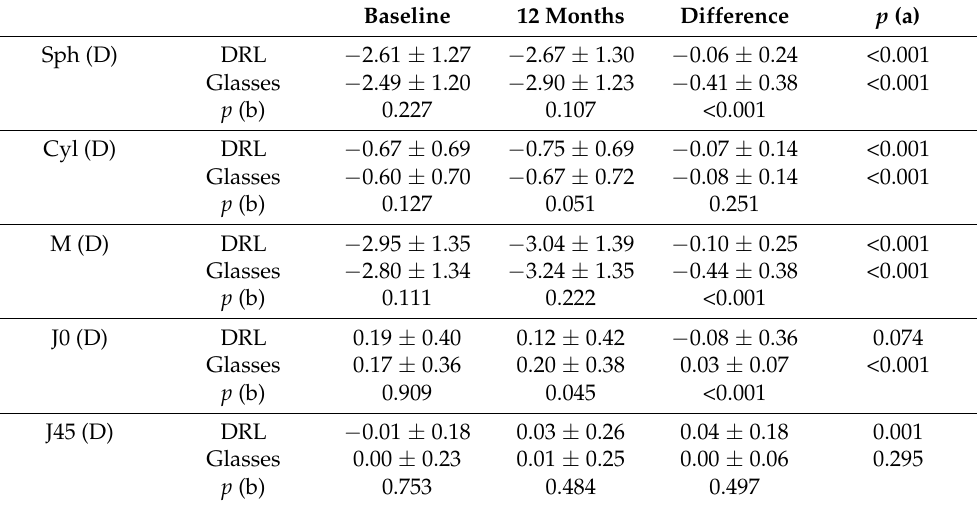
Table 3. Data from the longitudinal study at 12 months of treatment in the comparison between DRL and glasses ( n = 360).